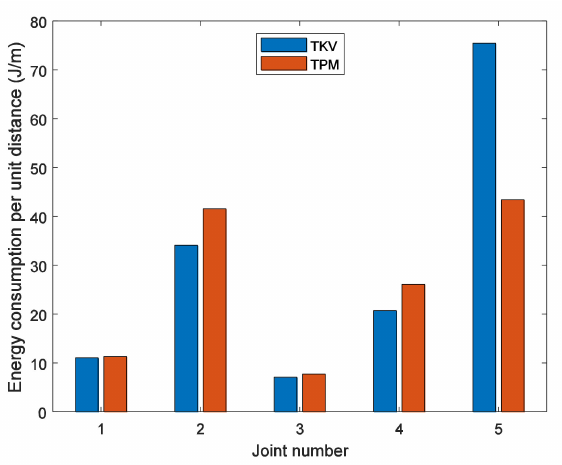
Figure 14. Energy consumption of each joint when gait period is 1.0 s and step length is 0.3 m.